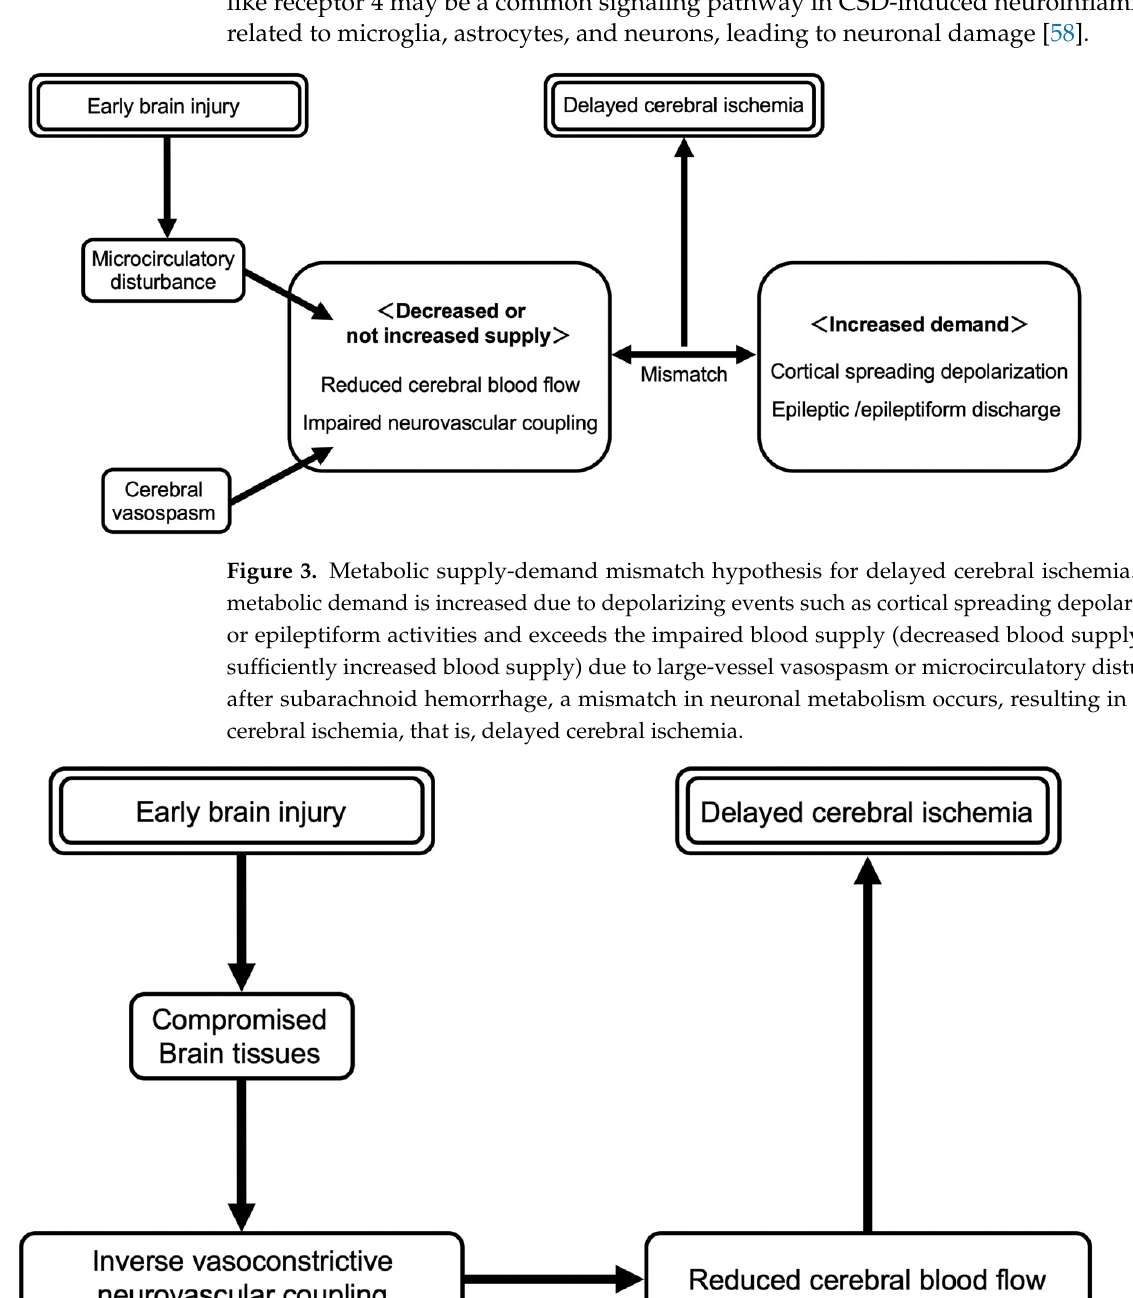
slow electrical potentials and silencing of brain electrical activities), resulting from and resulting in spreading the disturbance of ion homeostasis between intra- and extracellular space, leading to neuronal swelling, distortion of dendritic spines, glial depolarization, and damages as well as changes in the local vascular responses [86]. Epileptic activities are characterized by paroxysmal cellular depolarization shifts, which are correlated with a synchronous network event, resulting from possibly synchronous activation of recurrent excitatory paths and the consequent giant excitatory postsynaptic potentials [8]. Because the sustained depolarization underlying ictal epileptic field potentials remains below the inactivation threshold for the action potential-generating channels, neurons can continue synchronous, highly frequent firing that is superimposed on the moderate sustained de- polarization [8]. Interictal spikes and ictal epileptic field potentials spread between neu- rons at a rate usually higher than that of CSD through different mechanisms of spread [97]. Both CSDs with neuronal deactivation (near-complete sustained depolarization of neurons causing spreading depression) and seizures with neuronal activation (modest sustained depolarization allowing synchronous, highly frequent neuronal firing) have ex- citotoxic states as a common mechanism, and the link between them has been reported after aneurysmal SAH (Figure 2) [8]. Early CSD occurrence may be a risk factor for late post-SAH seizures [8].